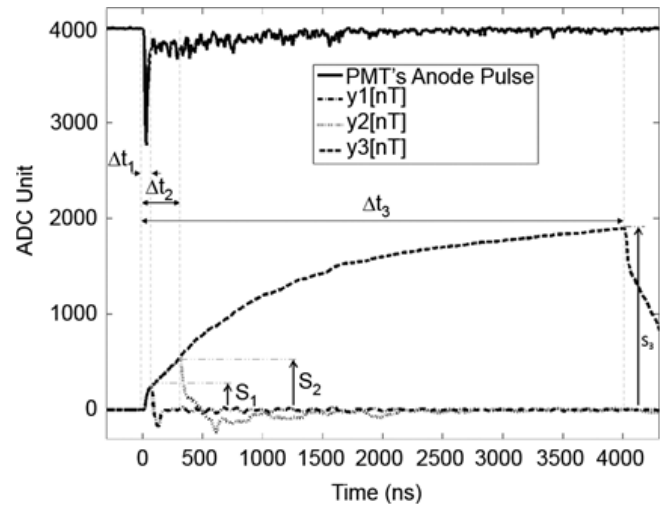
Figure 17. Pulse shape of the Phoswich detector with simultaneous measurement [48].